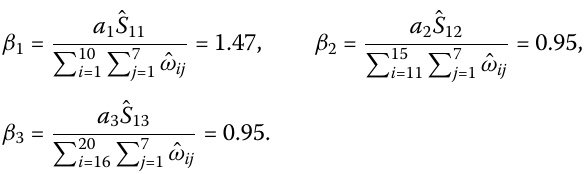
According to Fig. 11, the curves for identifying ω ij ( i = 1,2,...,20; j = 1,2,...,20) gradu- ally tend toward the fixed